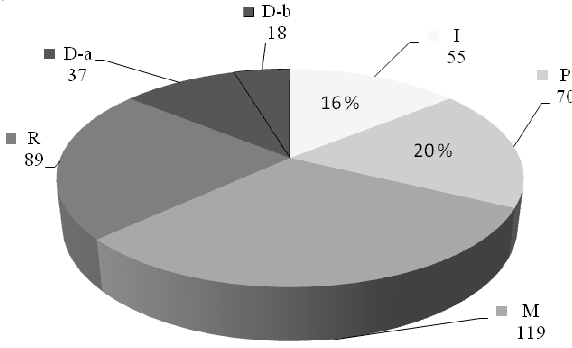
Figure 2. Frequency of occurrence and distribution of moves at sentence level.